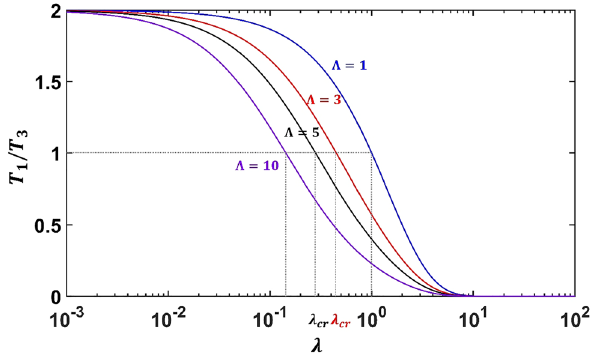
Figure 4. The ratio of T 1 /T 3 versus λ for different values of Λ. The area fraction c for the numerical illustration is specified as c = 1/4. Note that the figure will be identical to that of the HC-type interface if Λ is replaced by